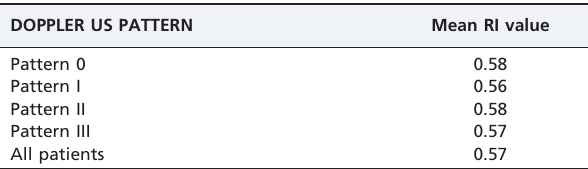
Table 5 - Mean RI values in patients with different Doppler